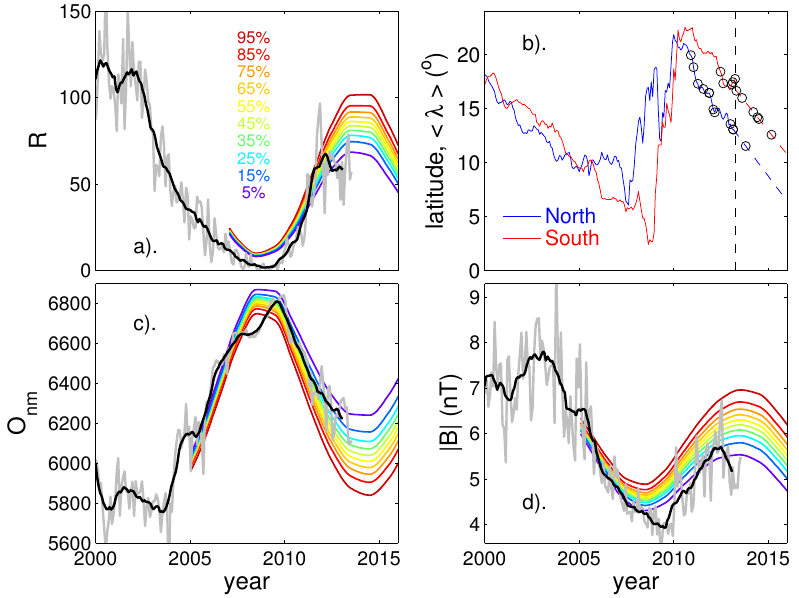
Figure 42: Update of Figure 40 summarising the evolution of solar cycle 24 thus far. Plot updated on 1 August